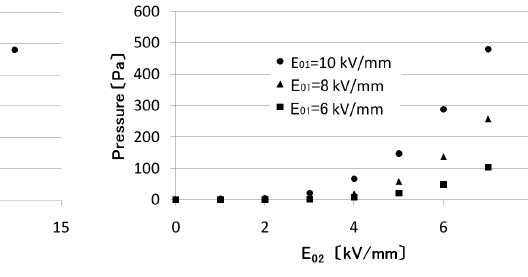
Fig. 14 Mean static pressure as a function of the electric